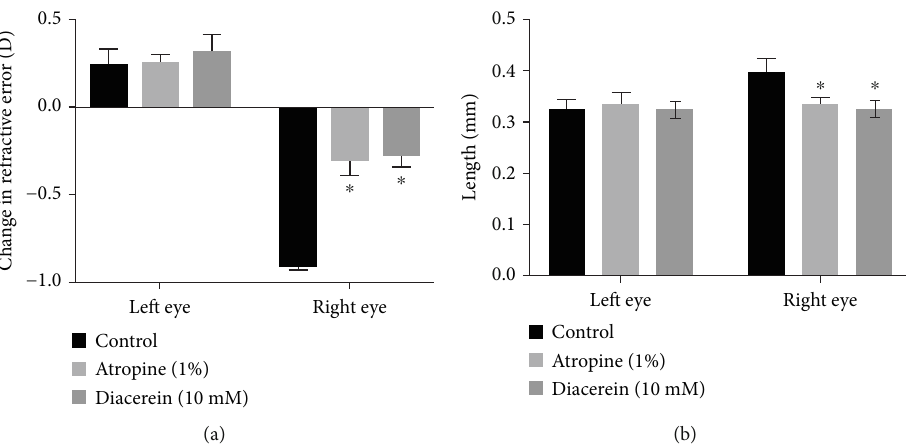
Figure 1: E ff ect of diacerein on myopia progression. (a) Right eye MFD-induced myopic shift in refraction error was inhibited by atropine (1%) and diacerein (10 mM). The ANOVA test was used to determine signi fi cant di ff erences and comparisons between control, atropine (1%), and diacerein (10 mM). The data are expressed as mean ± SD of three independent experiments. ∗ p < 0 : 05 compared with the control. (b) Right eye MFD-induced axial elongation was inhibited by atropine (1%) and diacerein (10 mM). The ANOVA test was used to determine signi fi cant di ff erences and comparisons between control, atropine (1%), and diacerein (10 mM). The data are expressed as mean ± SD of three independent experiments. ∗ p < 0 : 05 compared with the